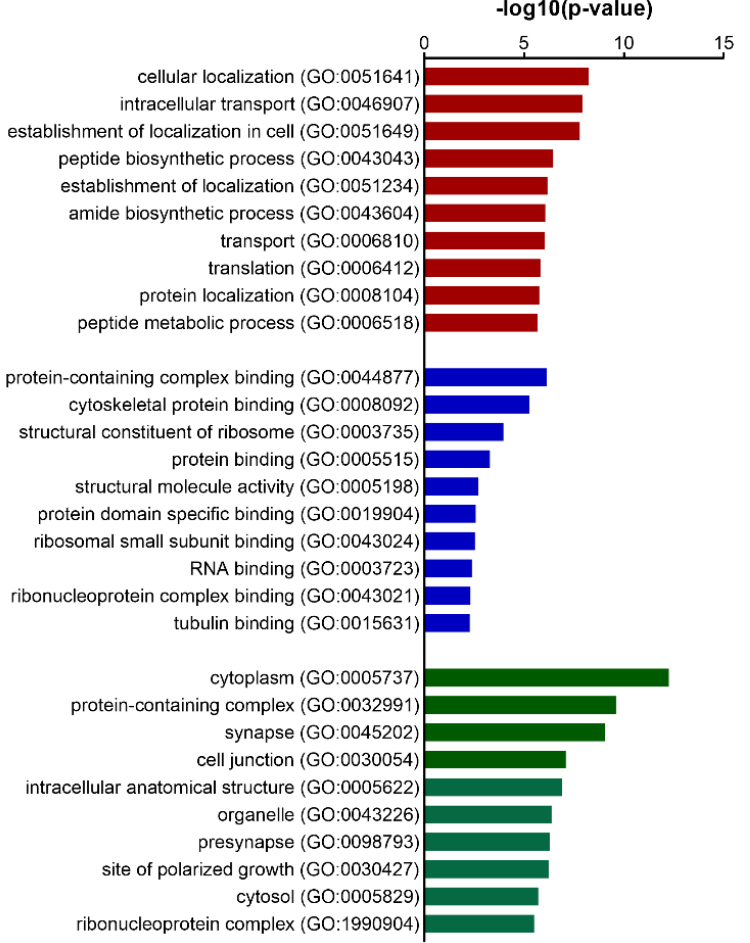
Figure 2. Gene Ontology analysis of the DEP list of 16-week L-NAME-untreated and -treated hippocampal tissue of C57BL/6 mice. Top 10 most significant GO hits for biological process (green bars), molecular function (blue bars), and cellular component (red bars). The y -axis depicts GO terms with their associated GO-ID, and the x -axis the associated − log10 ( p -value). Pathway enrichment analysis of the DEP list (Table 4) revealed a strong clustering of pathways involved in RNA surveillance (i.e., nonsense-mediated decay (nmd) independent of the exon junction complex (ejc)) and ribosomal translation (i.e., CAP- dependent translation initiation, eukaryotic translation initiation, GTP hydrolysis, and joining of the 60S ribosomal subunit) (Figure 3A).